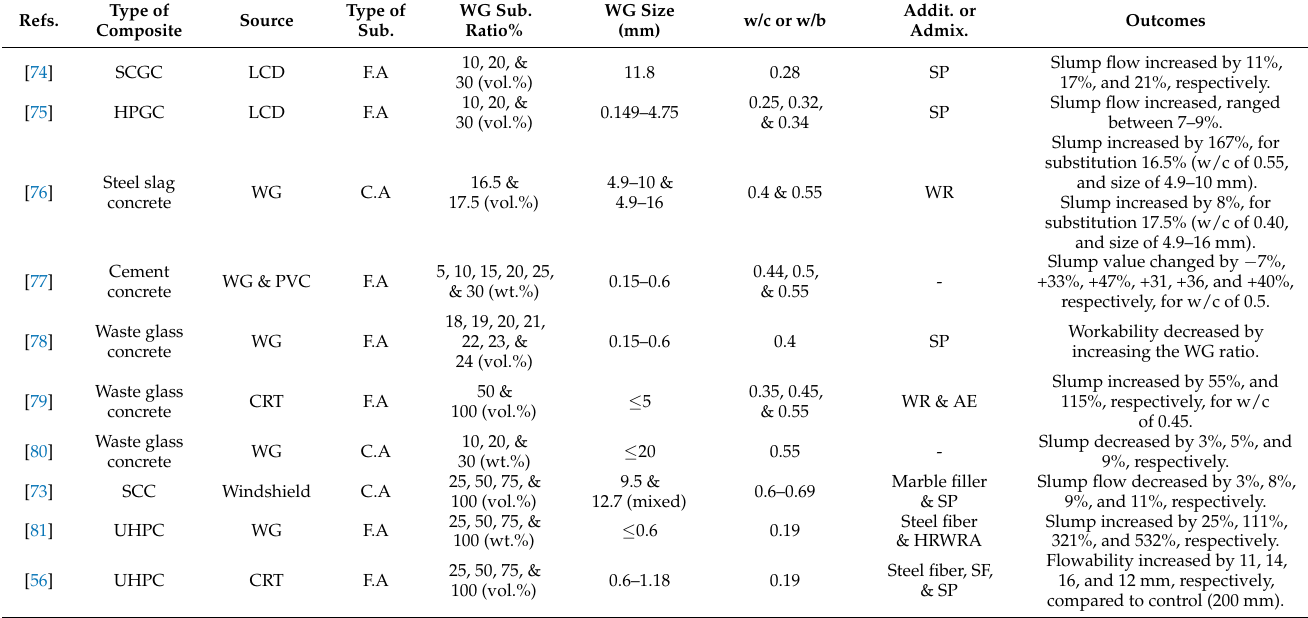
Table 5. Summary of the results of past studies on the workability of waste-glass